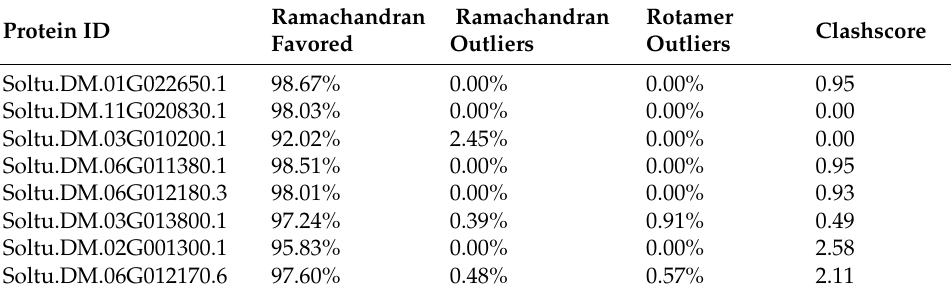
Table 3. Evaluation of StSOD AlphaFold